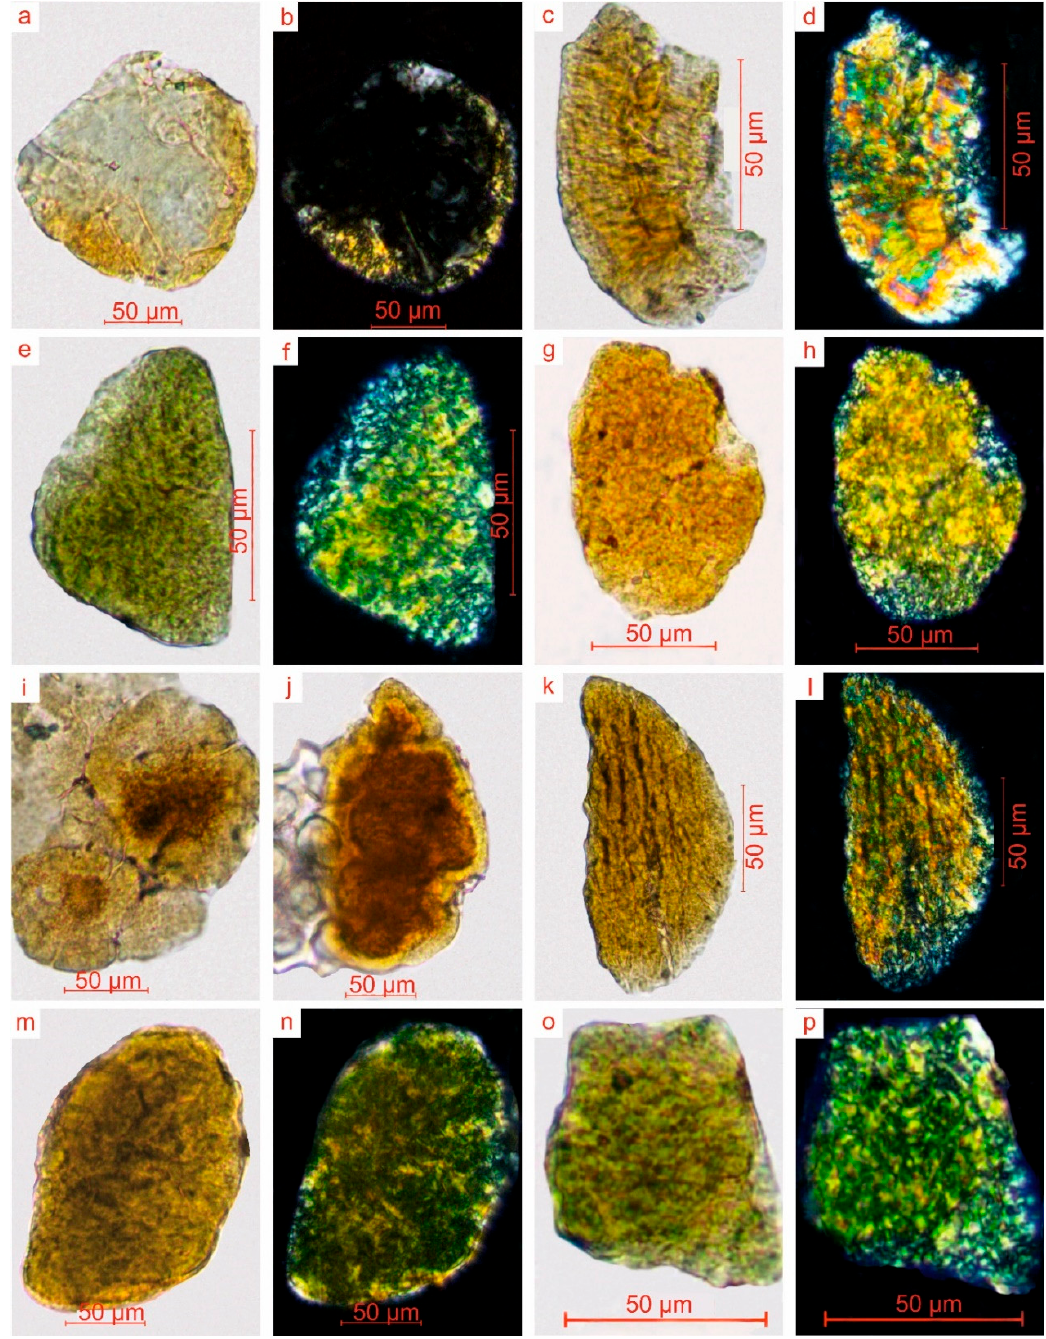
Figure 4. Mixed-layered illite–smectite formations in the rocks : ( a,b ) transformed volcanic glass fragment, rounded, with yellow rim (I morphotype): ( a ) parallel nicols; ( b ) crossed nicols; ( c,d ) lammelar-like highly inhomogeneous with high interreference colors (II morphotype); ( c ) parallel nicols; ( d ) crossed nicols; ( e,f ): semi-rounded yellow–green grains substrate on volcanic glass (III morphotype) ( e ) parallel nicols; ( f ) crossed nicols; ( g,h ) semi-rounded yellow grains (IV morphotype); ( g ) parallel nicols; ( h ) crossed nicols; ( i,j ) clay minerals formations with relics of biosiliceous substratum (V morphotype): ( i ) parallel nicols; ( j ) crossed nicols; ( k, l ) a volcanic glass fragment, sharply angular, with corrugated surface (VI morphotype): ( k ) parallel nicols; ( l ) crossed nicols; ( m,n ) highly rounded yellow grains substrate on volcanic glass (VII morphotype): ( m ) parallel nicols; ( n ) crossed nicols; ( o,p ) irregular shape green–yellow grains (VIII morphotype): ( o ) parallel nicols; ( p ) crossed nicols.